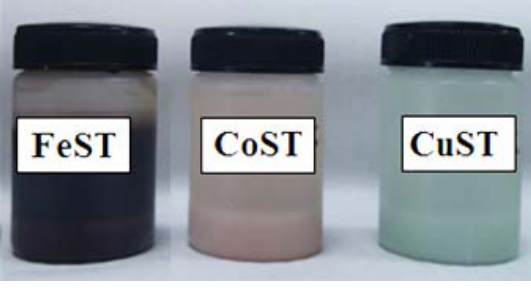
Figure 9. Pictorial representation of final materials, from left to right: Fe-starch (FeST), Co-starch (CoST) and Cu-starch